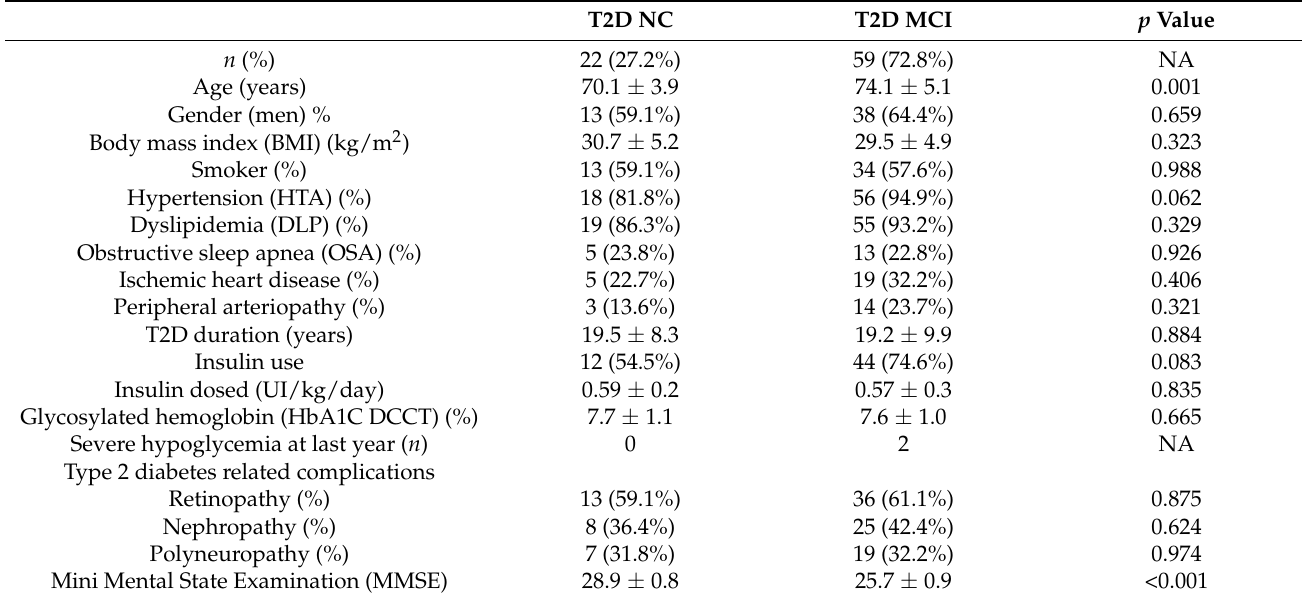
Table 1. Baseline characteristics of the patients.